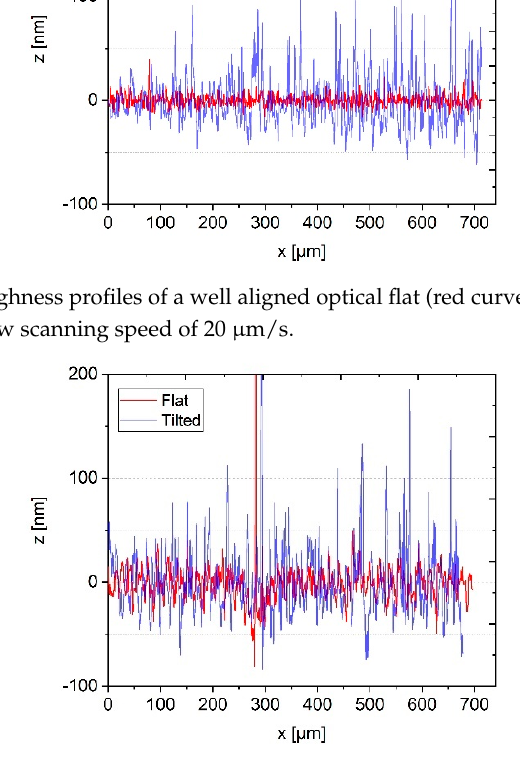
Figure 6. Measured roughness profiles of a well aligned optical flat (red curve) and an inclined optical flat (blue curve) for a high traverse speed of 1000 µm/s.